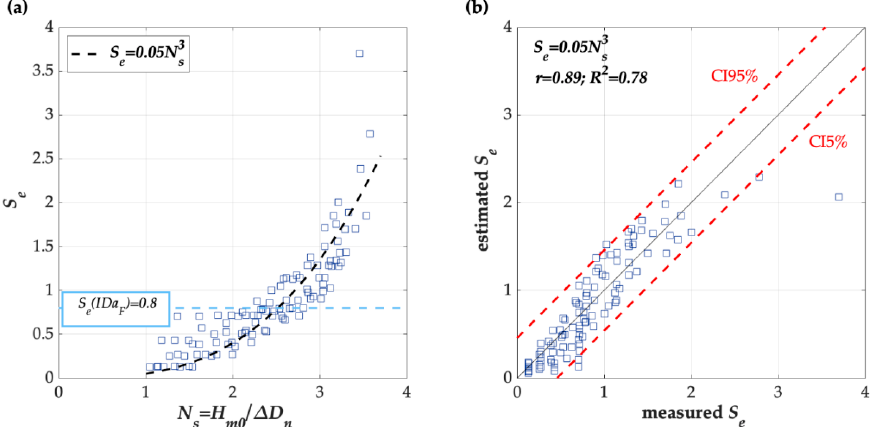
Figure 8. Performance of Equation (14) with K 1 = 0.05 and K 2 = 3 to estimate armor damage of the front slope of the cube-armored model: ( a ) Fitting to the measured data and IDa level, and ( b ) measured against estimated S e .